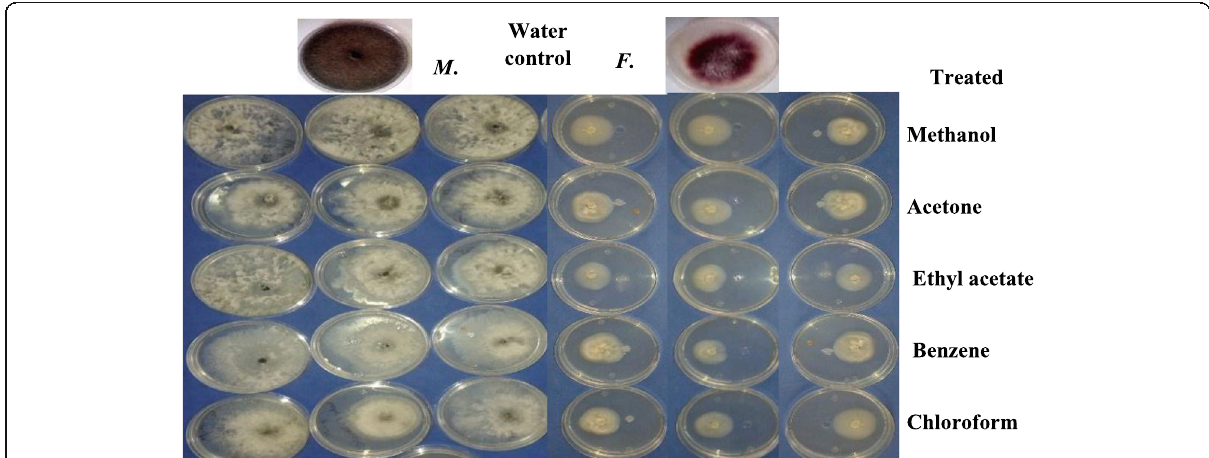
Fig. 1 Effect of different solvent extracts from green macroalgae on mycelial fungal growth of Macrophomina phaseolina and Fusarium sola ni on